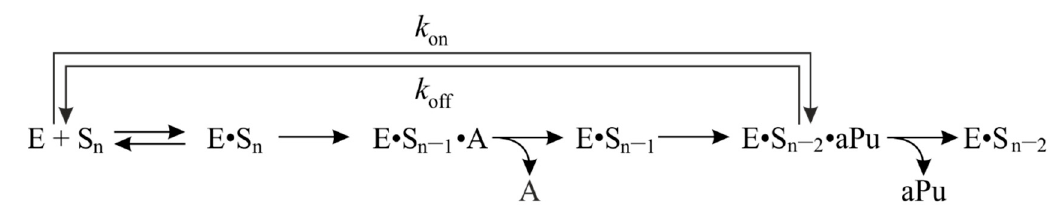
Table 2. Rate constants for interaction between Nfo and aPu 2 .